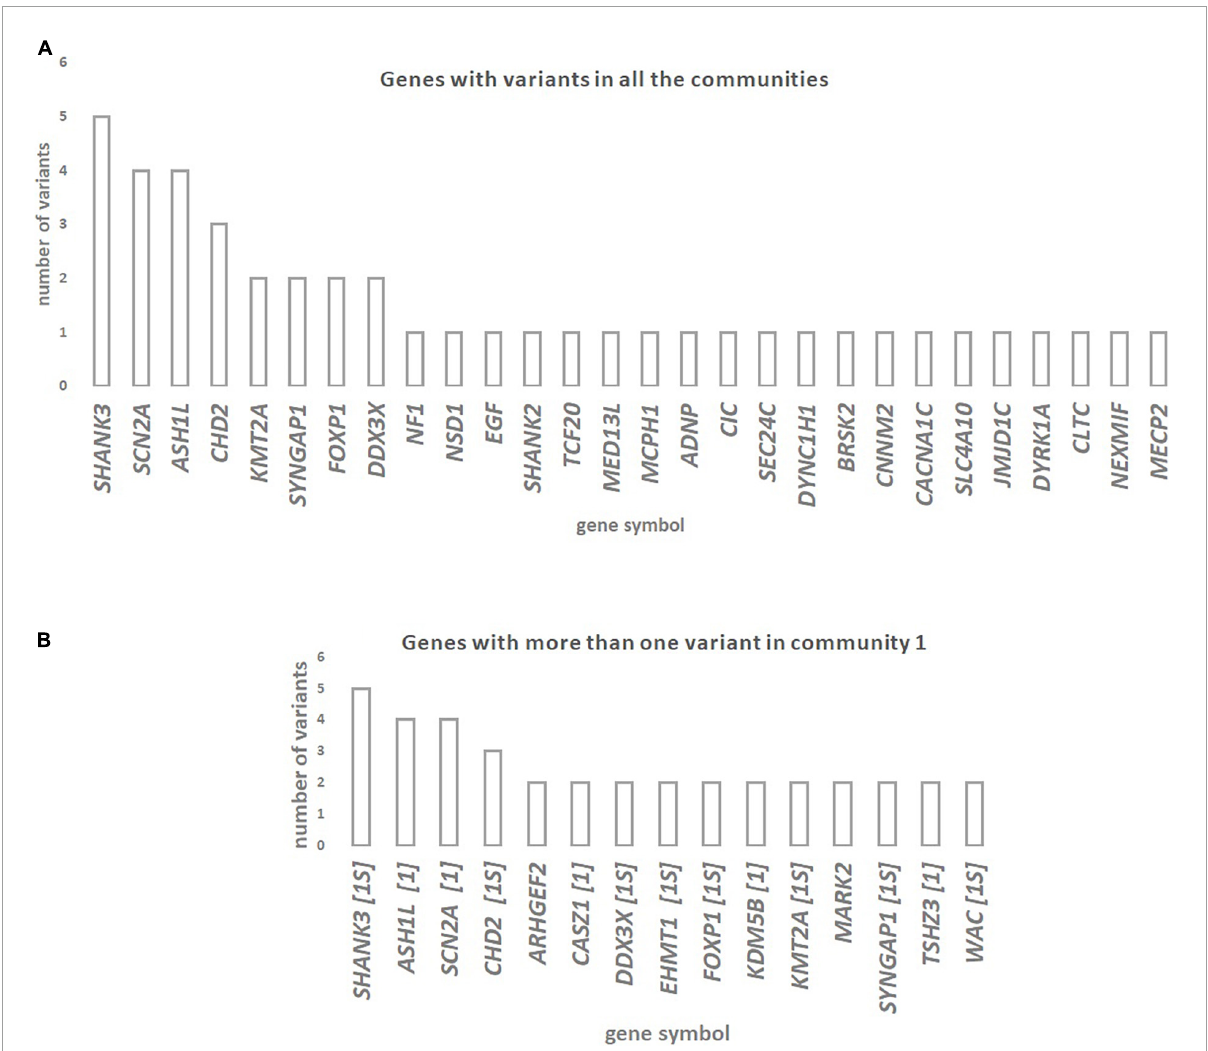
FIGURE2 (A) Genes with rare de novo LoF SNVs in ASD patients are shared across diseases from the three communities of the network of disease-disease similarities. (B) Genes with more than one rare de novo LoF SNV in ASD patients that are shared across Community 1 diseases (which includes ASD) of the network of disease-disease similarities. Whenever genes are also in the SFARI gene scoring module as candidate genes for ASD (https://gene.sfari.org/database/gene-scoring/), we display the evidence score next to the gene